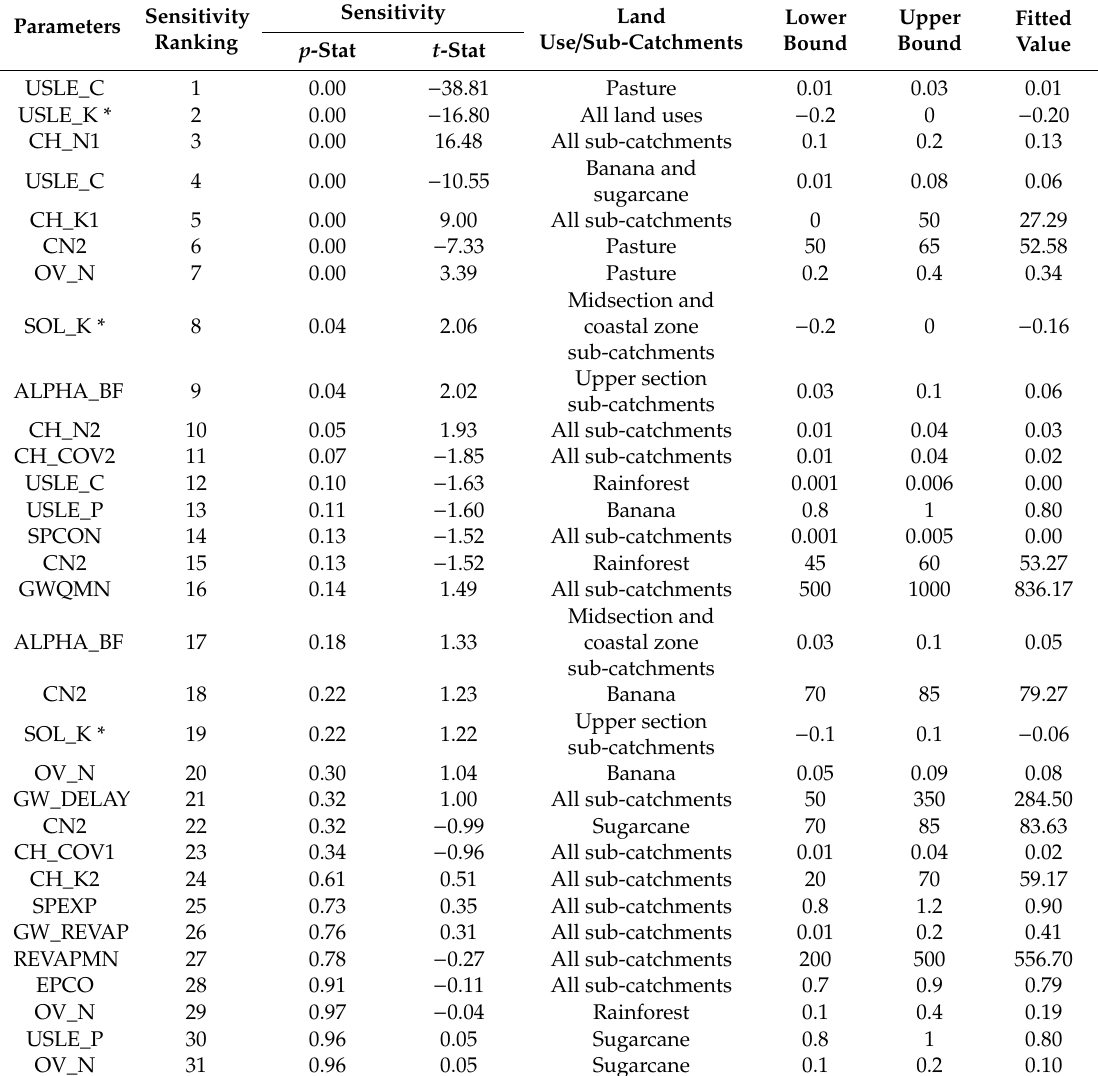
Table 3. Results of global parameter sensitivity analysis with Nash Sutcli ff e ffi ciency (NSE) as the objective function, including the lower and upper bound of parameters and the fitted